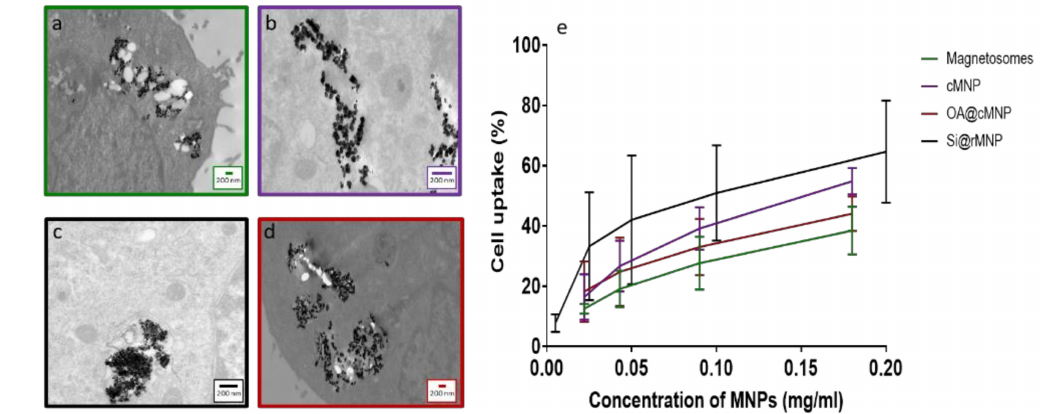
Figure 5. Intracellular uptake of magnetosomes and MNP. TEM slices of MDA-MB-231 cells after 24 h incubation ( a ) Magnetosomes, ( b ) cMNP, ( c ) Si@rMNP, ( d ) OA@cMNP, ( e ) uptake of magnetosomes and MNP via flow cytometry showing the percentage of cells with particles present magnetosomes, cMNP, Si@rMNP, and OA@MNP at concentrations of 0.022, 0.034, 0.17, and 0.35 mg/mL gated by granularity Si@rMNP were treated at concentrations of 0.005, 0.025, 0.05, 0.1, and 0.2 mg/mL and determined via the presence of a fluorescent marker Rhodamine B isothiocyanate.